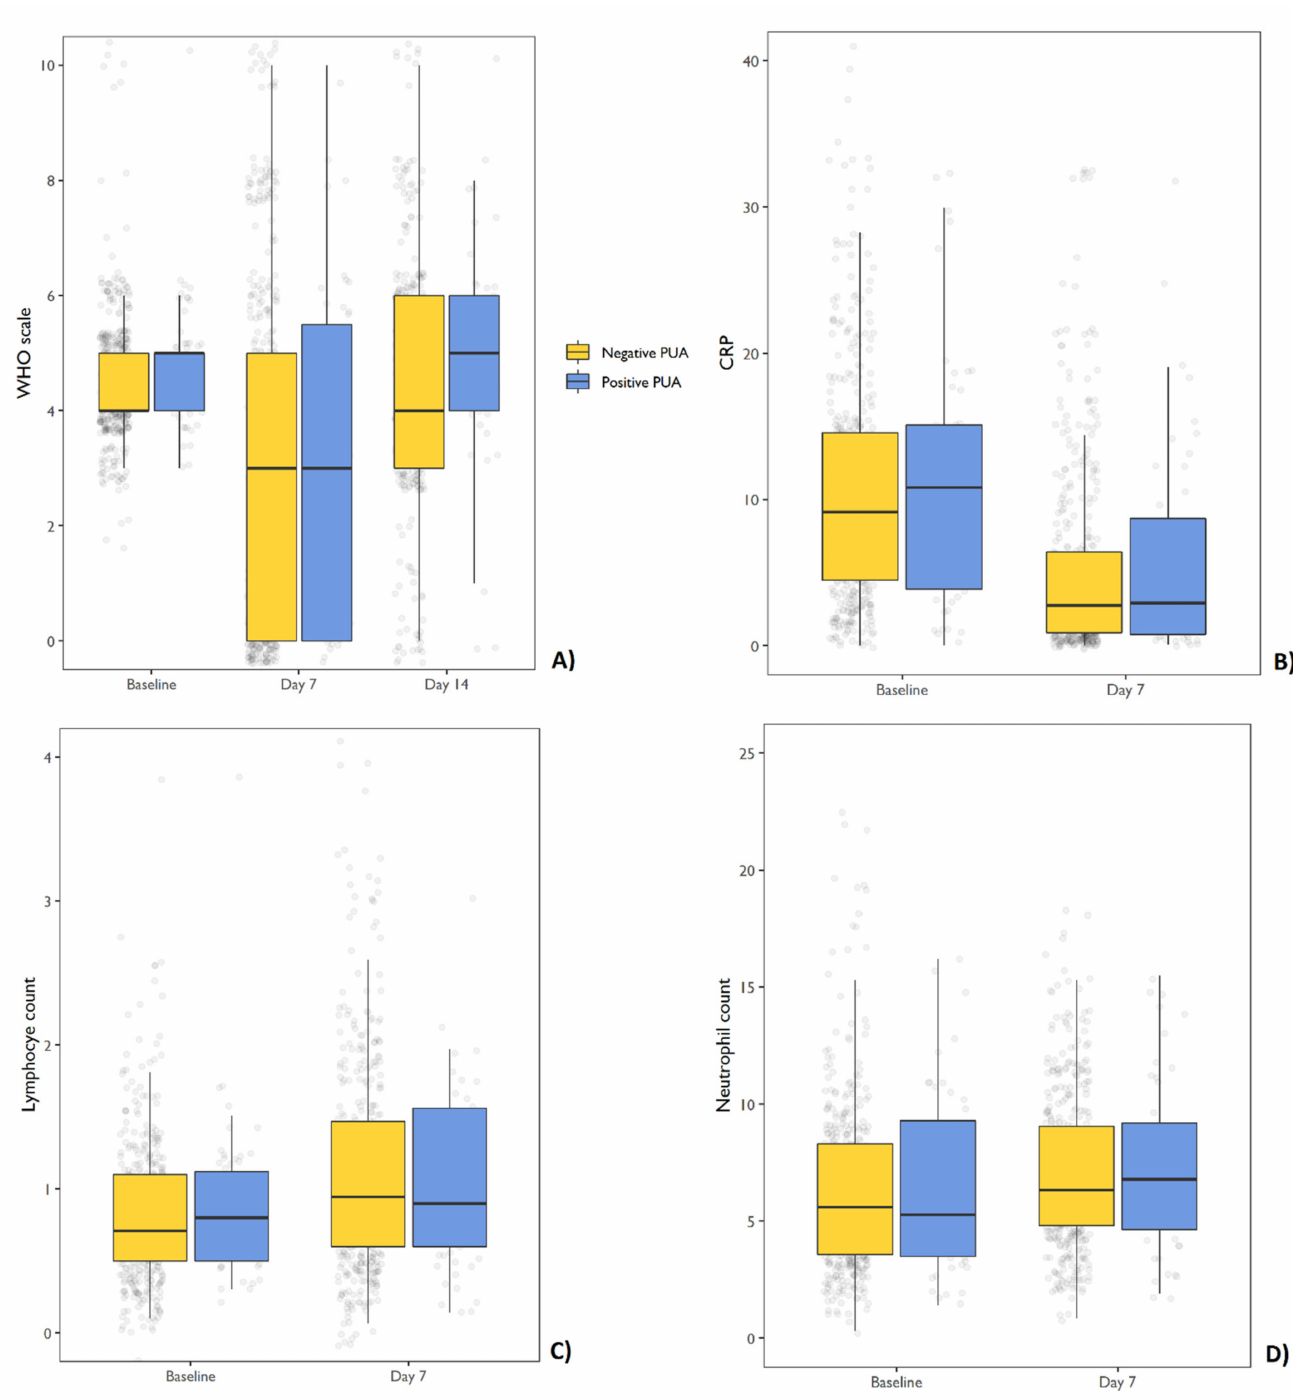
Figure 2. Box and whiskers charts. ( A ) Variation in WHO ordinal scale at 7 and 14 days from baseline. ( B ) Variations in CRP levels at 7 days from baseline; ( C ) variations in the neutrophil count at 7 days from baseline; ( D ) variation of the lymphocyte count at 7 days from baseline. Abbreviations CRP C-reactive protein, PUA pneumococcal urinary